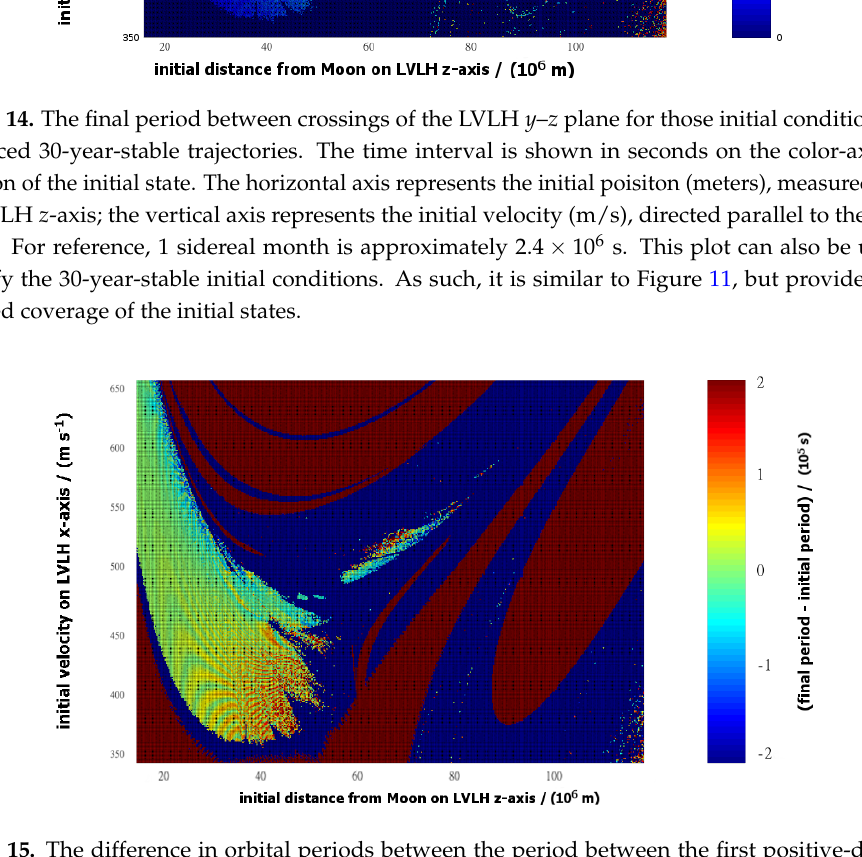
Figure 15. The difference in orbital periods between the period between the first positive-directed intersections with the y – z plane, and the period between the last recorded intersections of the same. The initial conditions that are not stable over 30 years are also shown. Those initial conditions that fail to produce a pass through the y – z plane are shaded dark red; those that complete one pass and subsequently become unstable are shaded dark